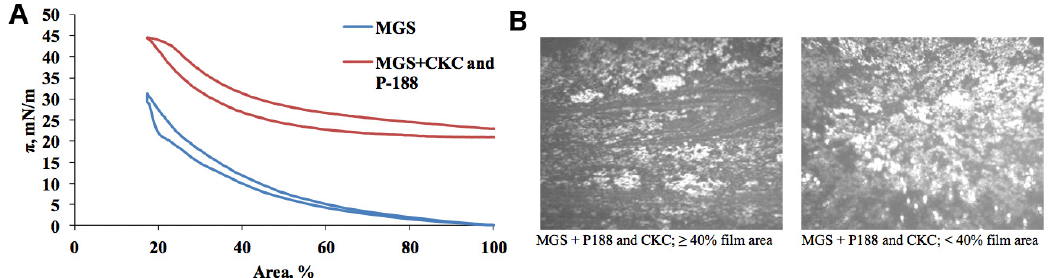
Figure 4. Meibomian gland secretion influenced by P188 and CKC. Surface pressure / area isotherms of MGS pure and over subphase containing 10 − 6 M P188 + 3.6 × 10 − 7 M CKC ( A ); BAM micrographs (500 × 500 µ m field of view) of MGS over subphase containing 10 − 6 M P188 + 3.6 × 10 − 7 M CKC ( B ).